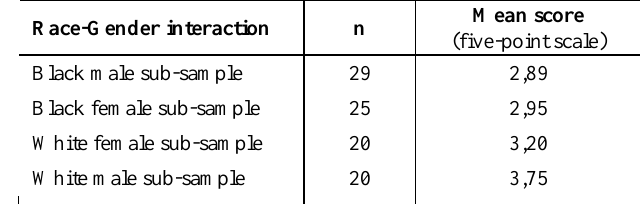
Table 5: ANOVA results: Two-way interactions between gender and race